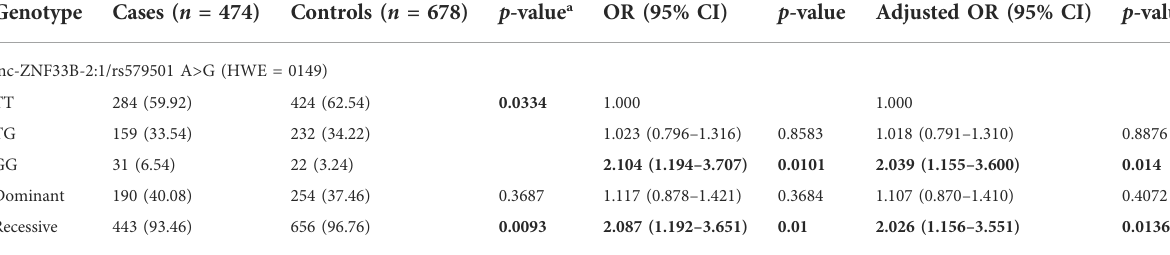
TABLE 3 Genotype frequency distribution of lnc-ZNF33B-2:1 in sepsis cases and healthy